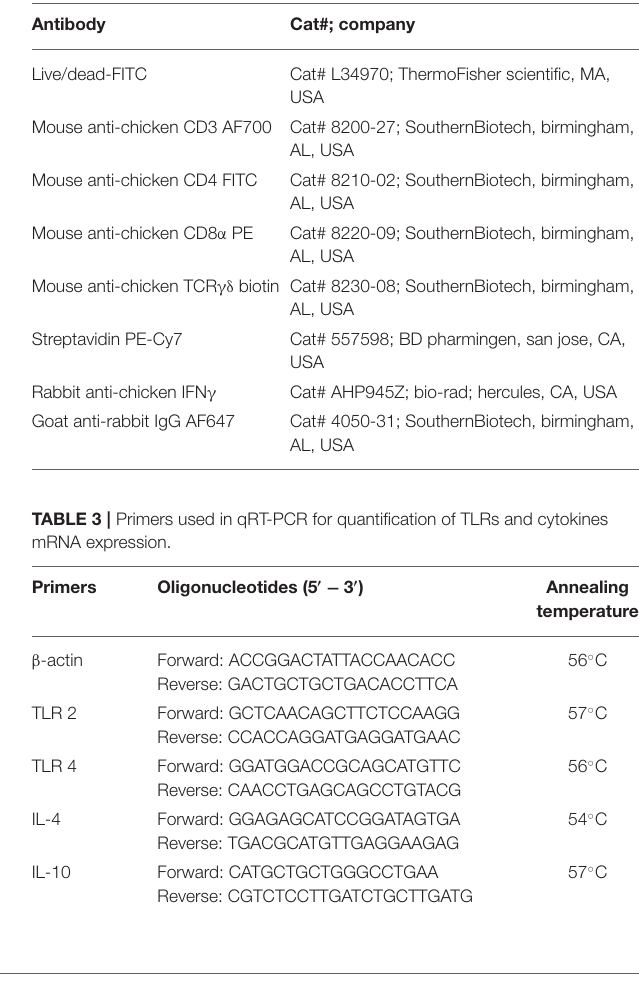
TABLE 2 | Antibodies used for cell surface and intracellular IFN γ staining.